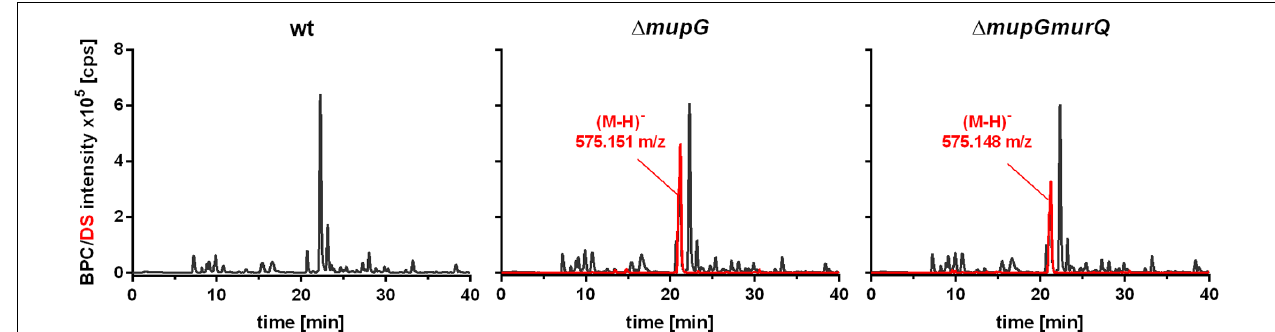
FIGURE 2 | Analysis of cytosolic extracts from wild type, (cid:49) mupG and (cid:49) mupGmurQ cells by LC-MS. S. aureus JE2 wild type (wt) and mutant strains were grown in LB medium for 24 h. Macromolecules were removed from the cytosolic fractions by acetone precipitation and soluble extracts were analyzed by LC-MS in negative ion-mode. Representative mass spectra from at least three independent experiments are presented as base peak chromatograms (BPC) ( × 10 5 counts per s [cps]) in black and as differential spectra (DS, BPC mutant – BPC wt ) ( × 10 5 [cps]) in red. DS of both mutants revealed the intracellular accumulation of a compound (absent in the wt cells) with an observed mass of (M-H) − = 575.151 m/z in (cid:49) mupG cells and an observed mass of (M-H) − = 575.148 m/z) in (cid:49) mupGmurQ